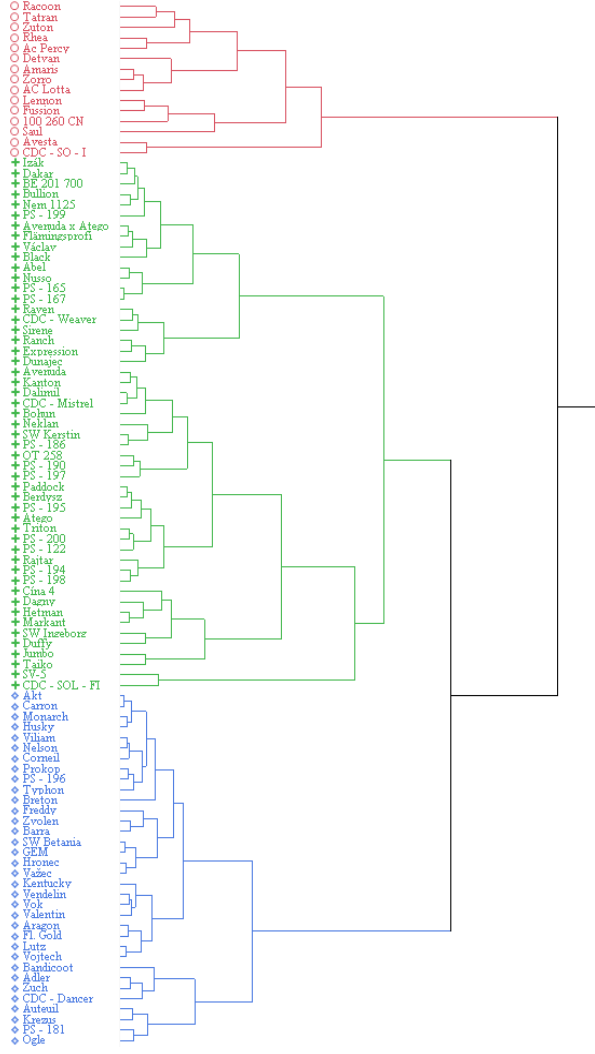
Figure 3: Cluster analysis of oats according to total polyphenols, total flavonoids, and radical scavenging